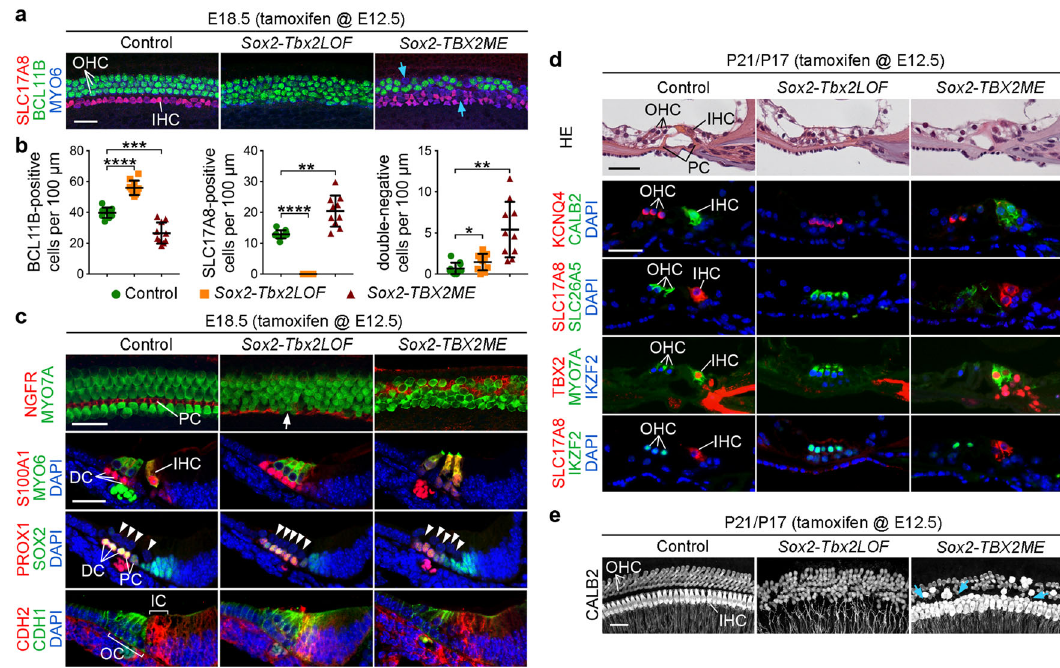
Fig. 2 | Tbx2 regulates the differentiation of cells in the inner compartment of theOrganofCorti.a – e Analysisof hairand supportingcelldifferentiationinmice at E18.5 ( a – c ) and P21/P17 ( d , e ) in which Tbx2 was ablated ( Sox2-Tbx2LOF ) or misexpressed ( Sox2-TBX2ME ) in prosensory cells by tamoxifen administration at E12.5. Note that we used male Sox2-TBX2ME mice, which misexpress TBX2 homo- genously, for analysis at E18.5, and female Sox2-TBX2ME mice, which express the transgene in a mosaic fashion due to random X-chromosome inactivation, for analysis at P17. a , b Co-immuno fl uorescence analysis of expression of SLC17A8 (marksIHCs),BCL11B(marksOHCs)andMYO6(marksallhaircells)onE18.5whole cochleae( a )andquanti fi cation( b